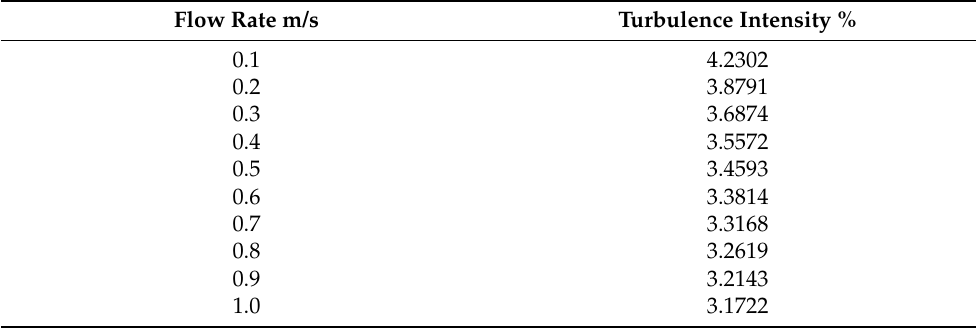
Table 5. Turbulence intensity of chloroform at each flow rate for a diameter of 0.15 m.